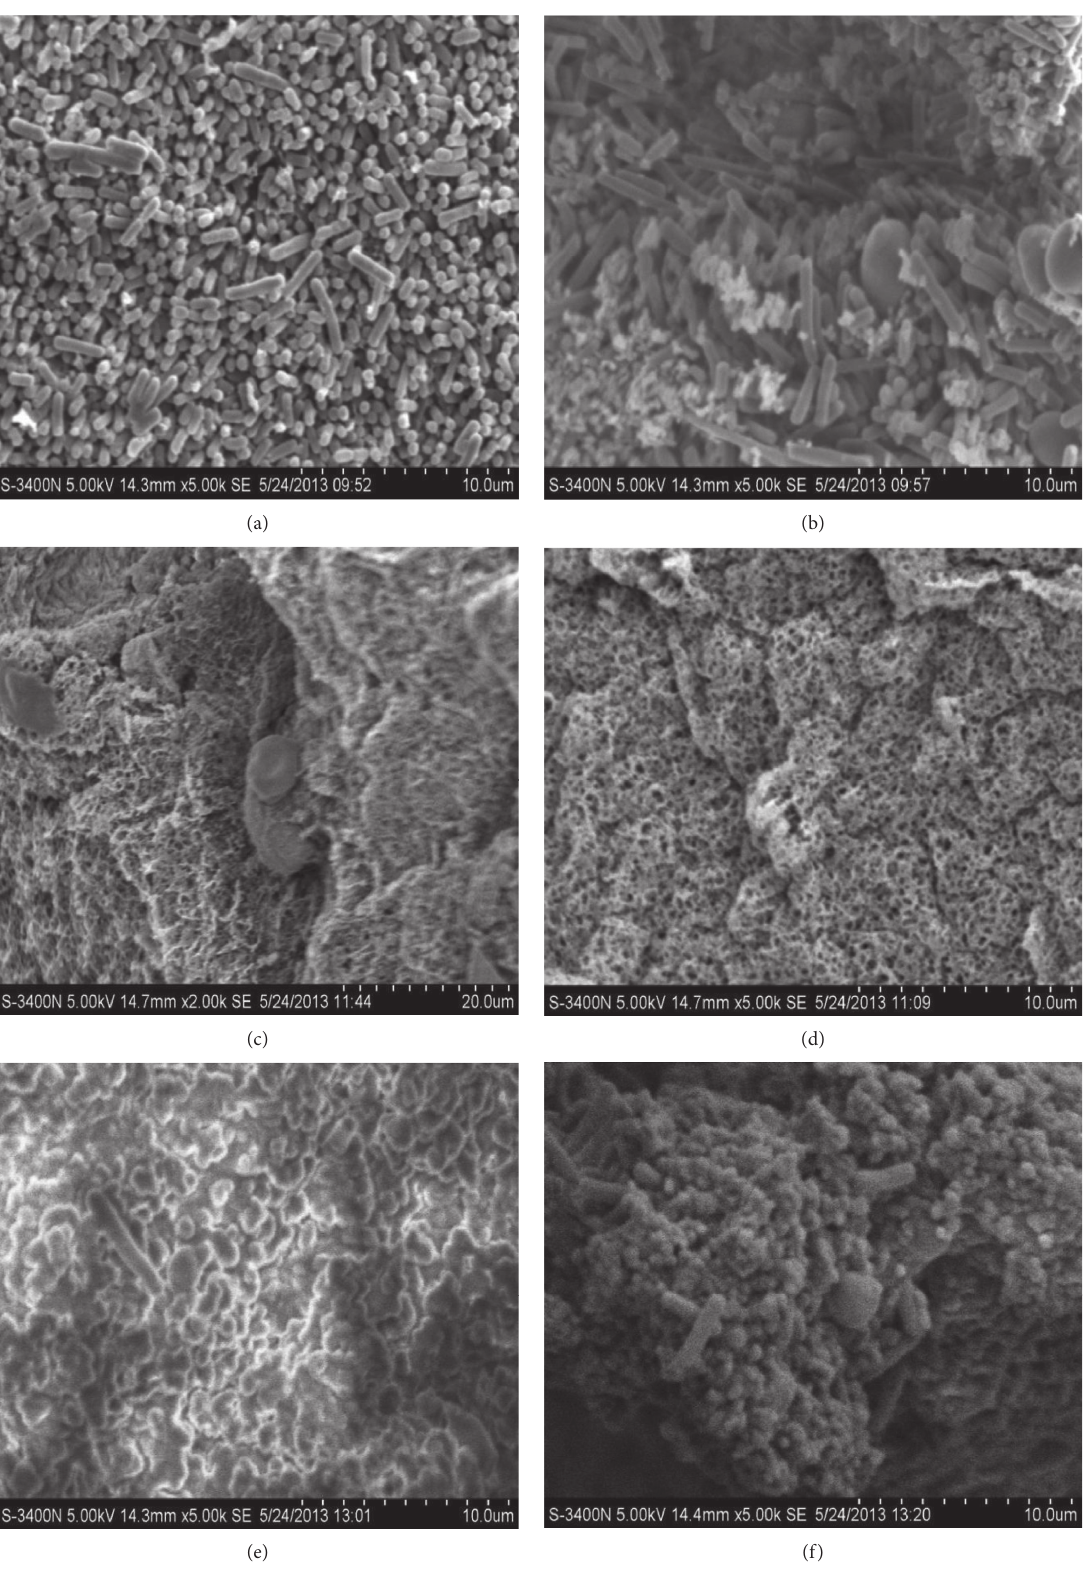
Figure 2: Scanning electron micrographs of natural kefir grains and different vectors: the external structure of (a) natural kefir grains, (c) encapsulated vector, and (e) cheese vector. The internal structure of (b) natural kefir, (d) encapsulated vector, and (f) cheese